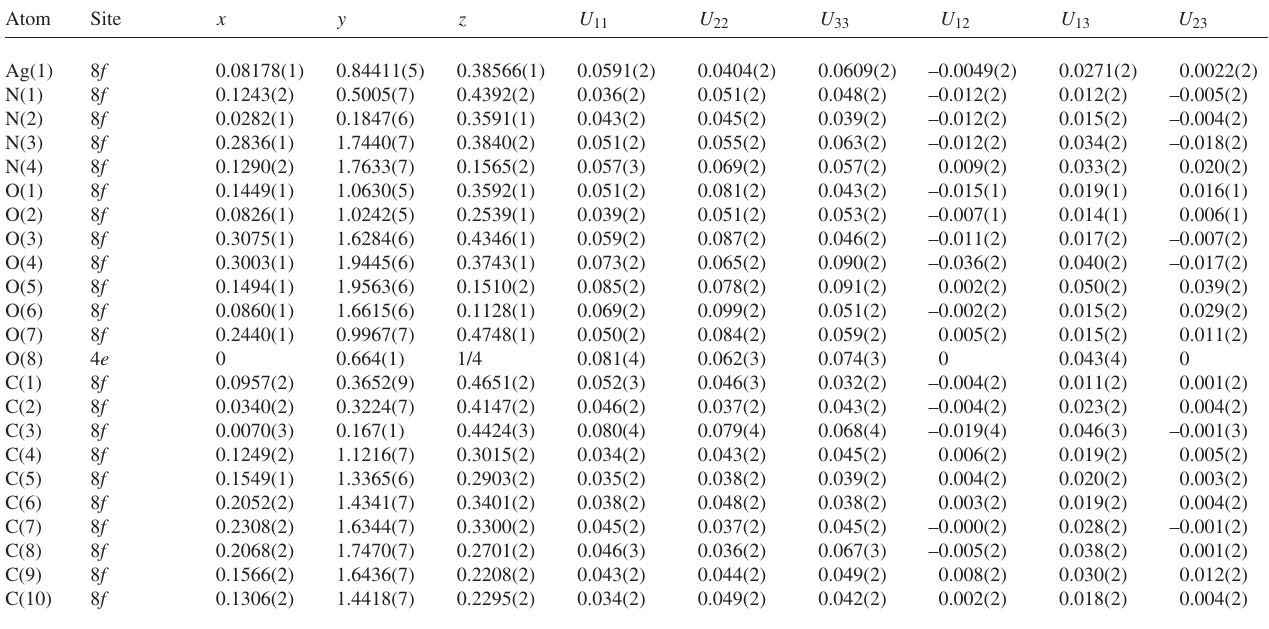
Table 3. Atomic coordinates and displacement parameters (in Å 2 ) .